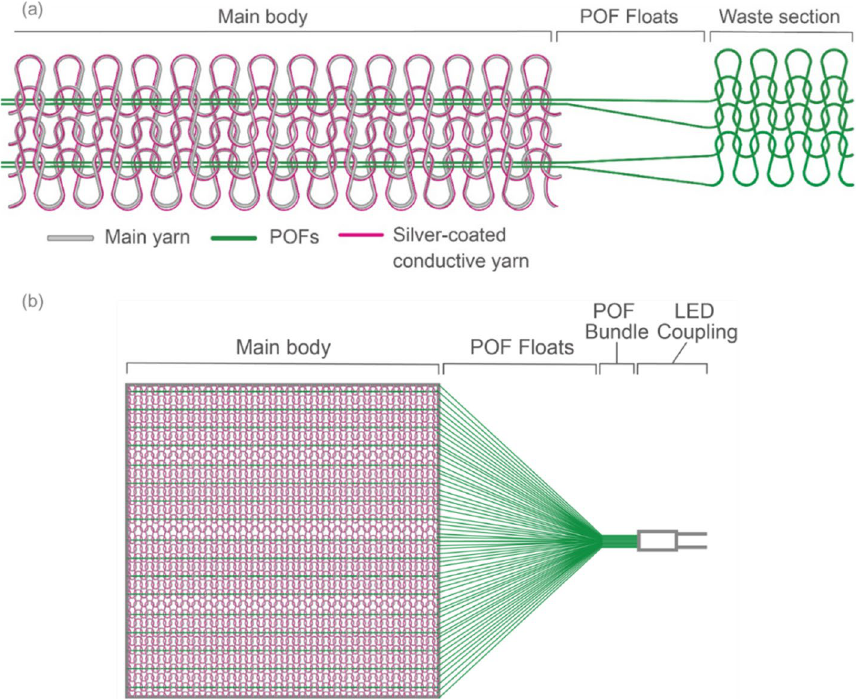
Fig. 3 Diagram showing a the ‘waste section’, part of the polymeric optical fibre (POF) floats knitted into the main body of knitted textiles, and b the POF bundle attached to a light source (LED coupling)